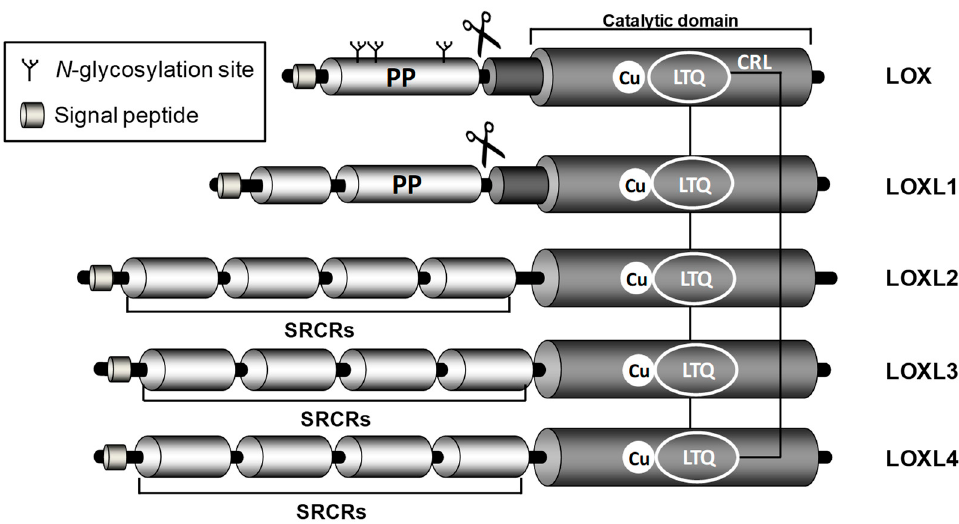
Figure 2. Structure of human LOX isoenzymes. The scheme evidences the high homology of LOX/LOXs isoenzymes in the C-terminal region, formed by the conserved catalytic domain which encompasses the copper binding site and the lysyl tyrosyl quinone (LTQ) cofactor region. The C-terminal region also includes the cytokine receptor-like (CRL) domain. LOX and LOXL1 propeptide sequences (PP) and the site recognized by BMP1 (symbolized by scissors), which allows the cleavage of these isoenzymes and the release of the active forms, are shown. The N -glycosylation sites at the LOX-PP region are outlined. LOXLs isoenzymes contain four scavenger receptors cysteine-rich (SRCR) domains probably involved in protein–protein interaction.